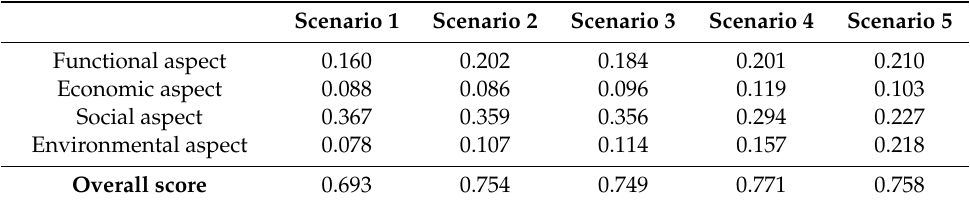
Table A14. Obtaining the criteria and overall